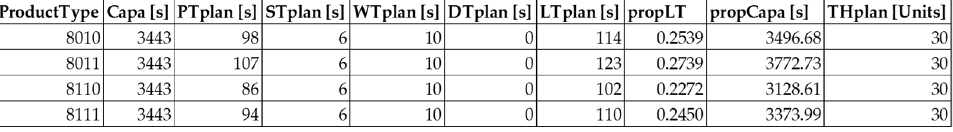
Figure 16. Data to create the production schedule for test series two.